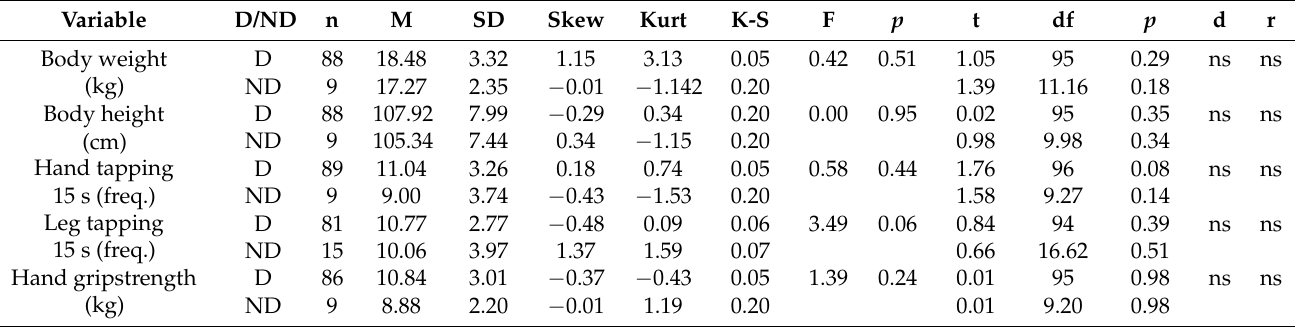
Table 2. Comparison of a body’s dominant (D) and non-dominant (ND) sides in boys and girls of 3- to 6-year old